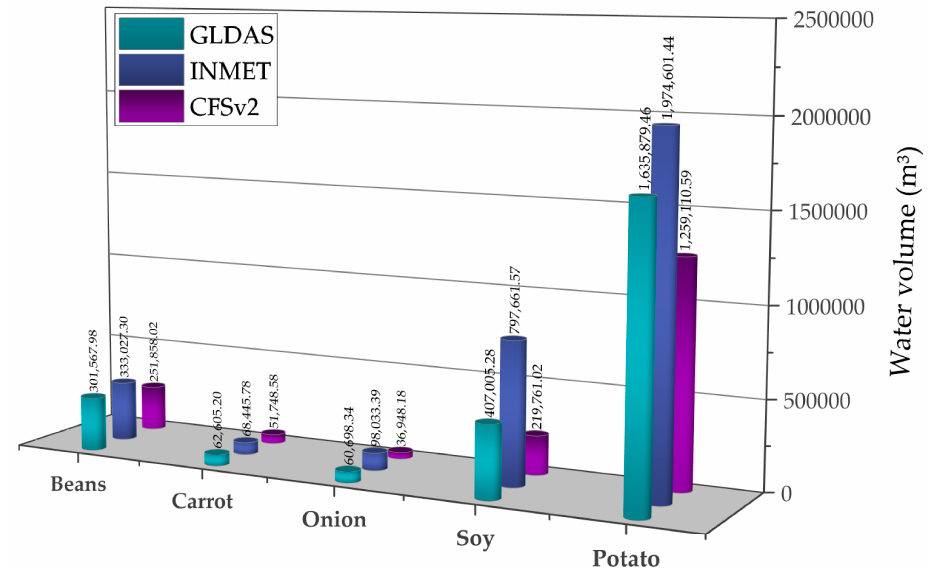
Figure 12. Water use volume estimated in the irrigation crops cultivated in the center pivots located in the study area for the agricultural year 2015/2016. The volume was estimated for crops that presented positive irrigation balance.